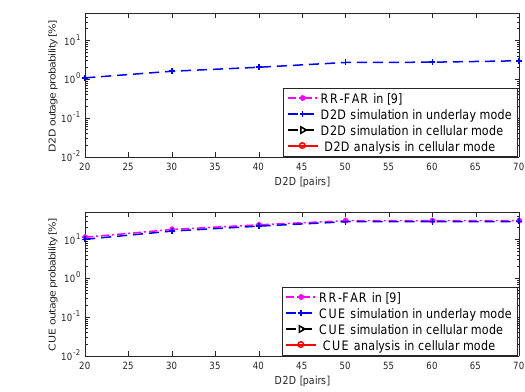
Fig. 6: D2D and CUE cell outage probability as func- tion of the number of D2D pairs in underlay mode scheme) and cellular mode ( CELLM ) for CUE (D2D) transmission power of 24 dBm (21